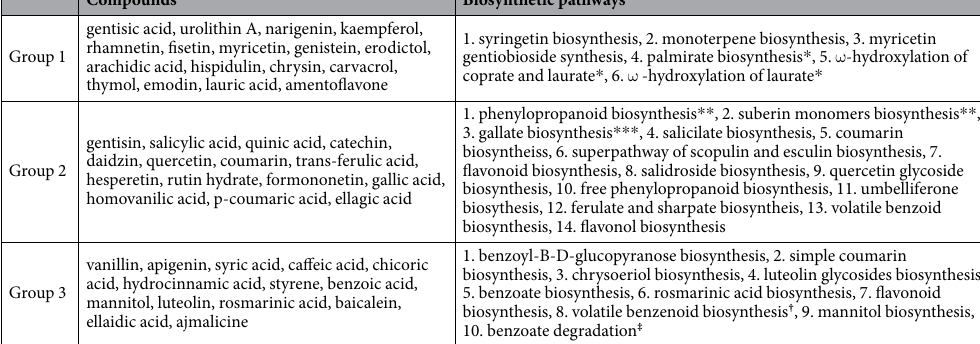
Table 1. Highly correlated compounds. Hierarchal clustering using Pearson correlation divided metabolites into three groups of highly correlated compounds. The biosynthetic pathways covered by each group were identified using the Plant Metabolic Network Pathway Tool. A heat map showing the correlations among compounds is in Supplementary Materials Figure 7. All compounds are part of secondary metabolic networks unless otherwise noted. Compounds formed in other biosynthetic pathways are denoted as follows: * fatty acid biosynthesis; ** cell structure; *** amine/polyamine biosynthesis; † carbohydrate biosynthesis; ‡ aromatic compound